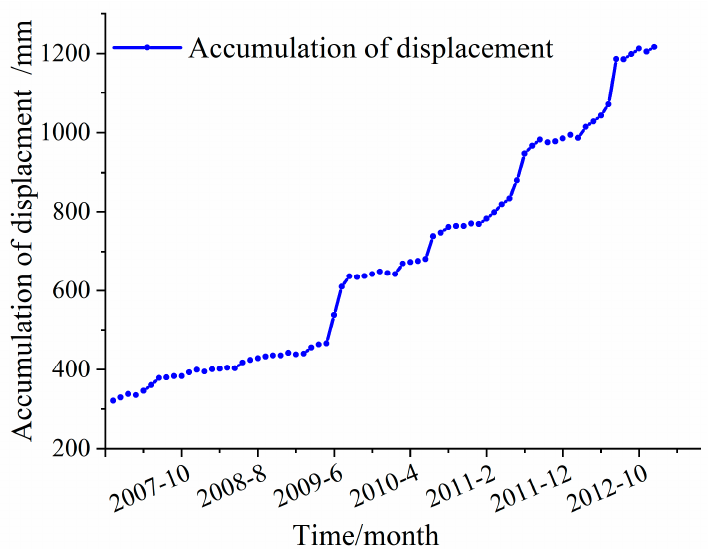
Figure 9. the Accumulative displacement curve of the step type landslide. Figure 9. The Accumulative displacement curve of the step type